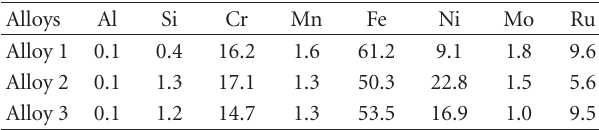
Figure 2: Optical microstructures of laser alloyed AISI 316 SS: (a) alloy 1 (9.6% Ru) and (b) alloy 2 (5.6% Ru). Table 2: EDX elemental composition of the laser alloyed layer (wt%) with an error of 0.2wt%.